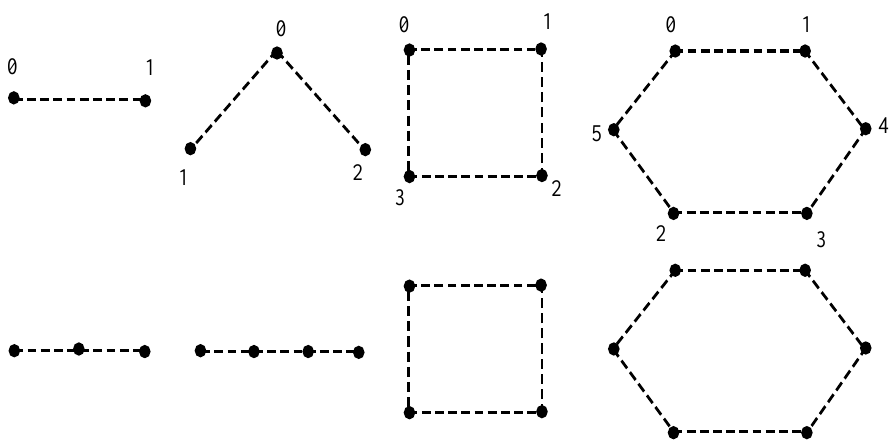
Figure 7. Showing Σ ∧